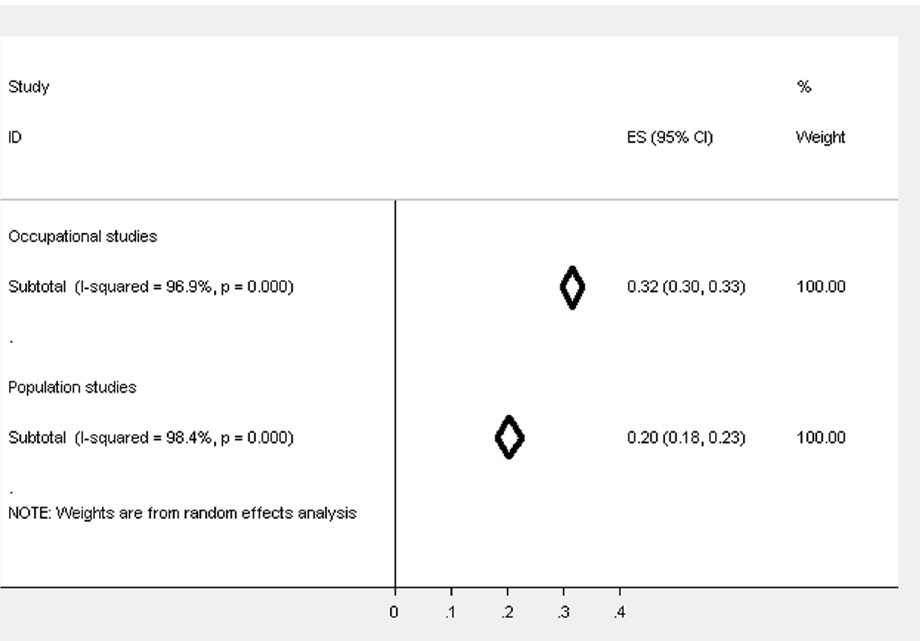
Figure 4. Forest plot displaying the weighted estimates for CMD caseness between the occupational and population studies.